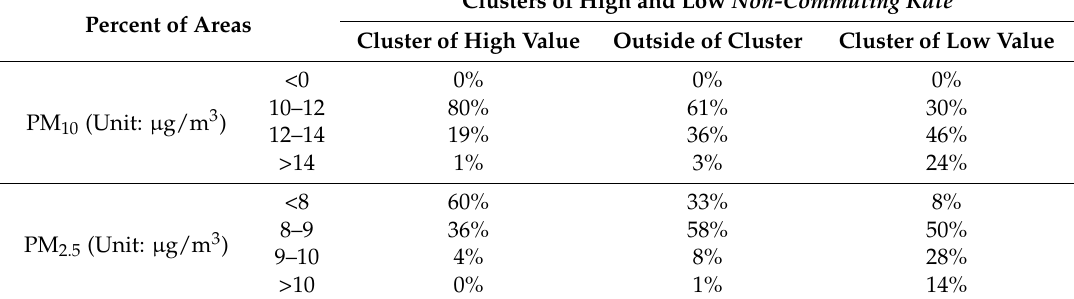
Table 3. Percentages of areas of clusters of high and low non-commuting rate with different levels of PM 10 and PM 2.5 .